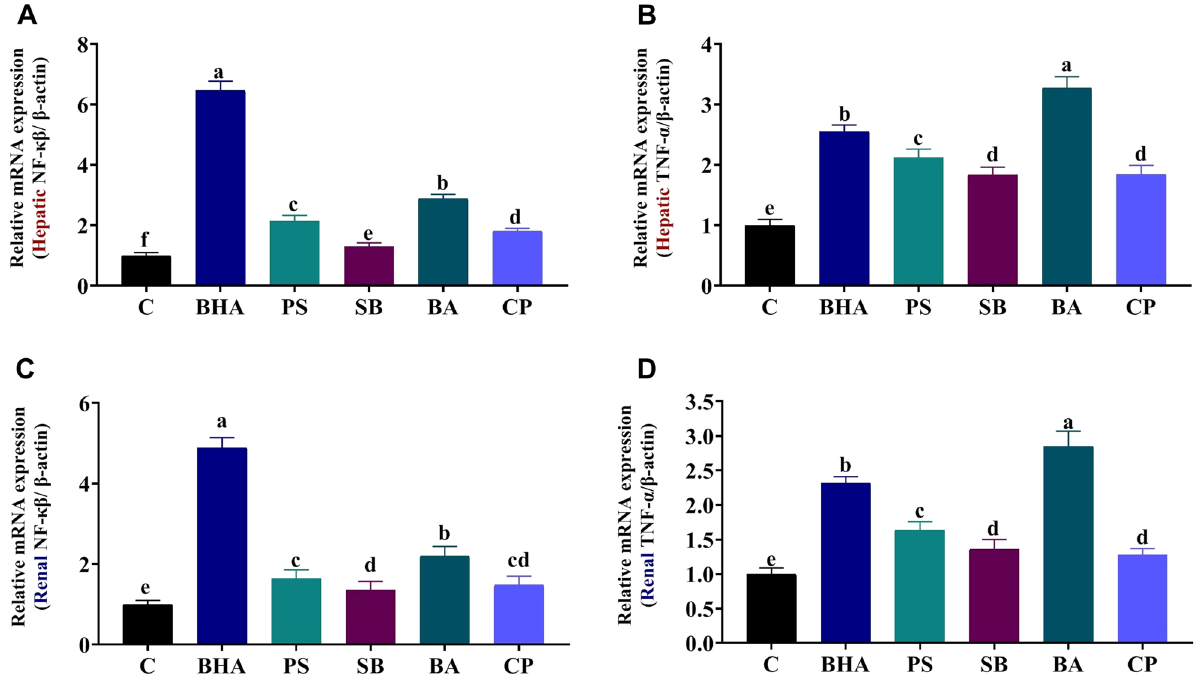
Figure 2. Expression of nuclear factor-kappa B (NF-κB) and tumor necrosis factor-alpha (TNF-α) in the hepatic and renal tissues of butylated hydroxyanisole (BHA), potassium sorbate (PS), sodium benzoate (SB), boric acid (BA), or calcium propionate (CP)- treated rats. β-Actin was used as the internal control. Data are expressed as the mean ± SE (n = 3 replicates). Columns with different superscripts are significantly different (one- way ANOVA, p <